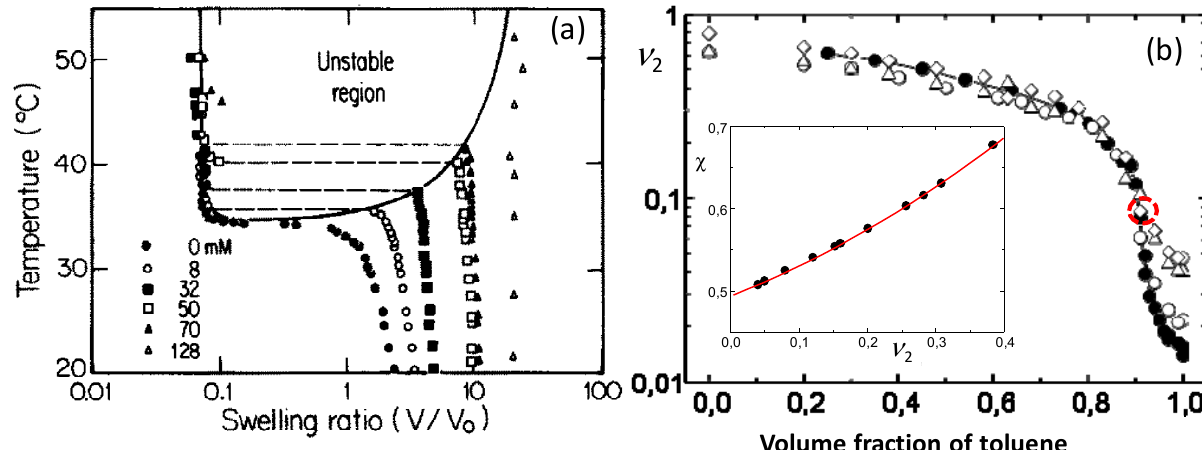
Figure 3. ( a ) Equilibrium swelling ratio ( V/V o ) of ionized PNIPAM hydrogels in water plotted against the temperature. The amount of ionizable sodium acrylate incorporated in 700 mM NIPAM is indicated. From [26] with permission from the American Institute of Physics. ( b ) The polymer volume fraction υ 2 of PIB organogels in toluene/methanol mixtures shown as a function of the toluene content. PIB gels with the lowest crosslink density ( M c = 380 kg · mol − 1 ) are represented by the filled circles. The inset shows the dependence of χ parameter on the υ 2 for PIB-toluene/methanol system. From [27] with permission from the American Chemical Society.